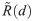
Power performance of test statistics R˜(d) across a grid of d under alternative hypothesis (1) with parameter μo = 375.The solid points indicate the maximum power for the particular parameter setting.